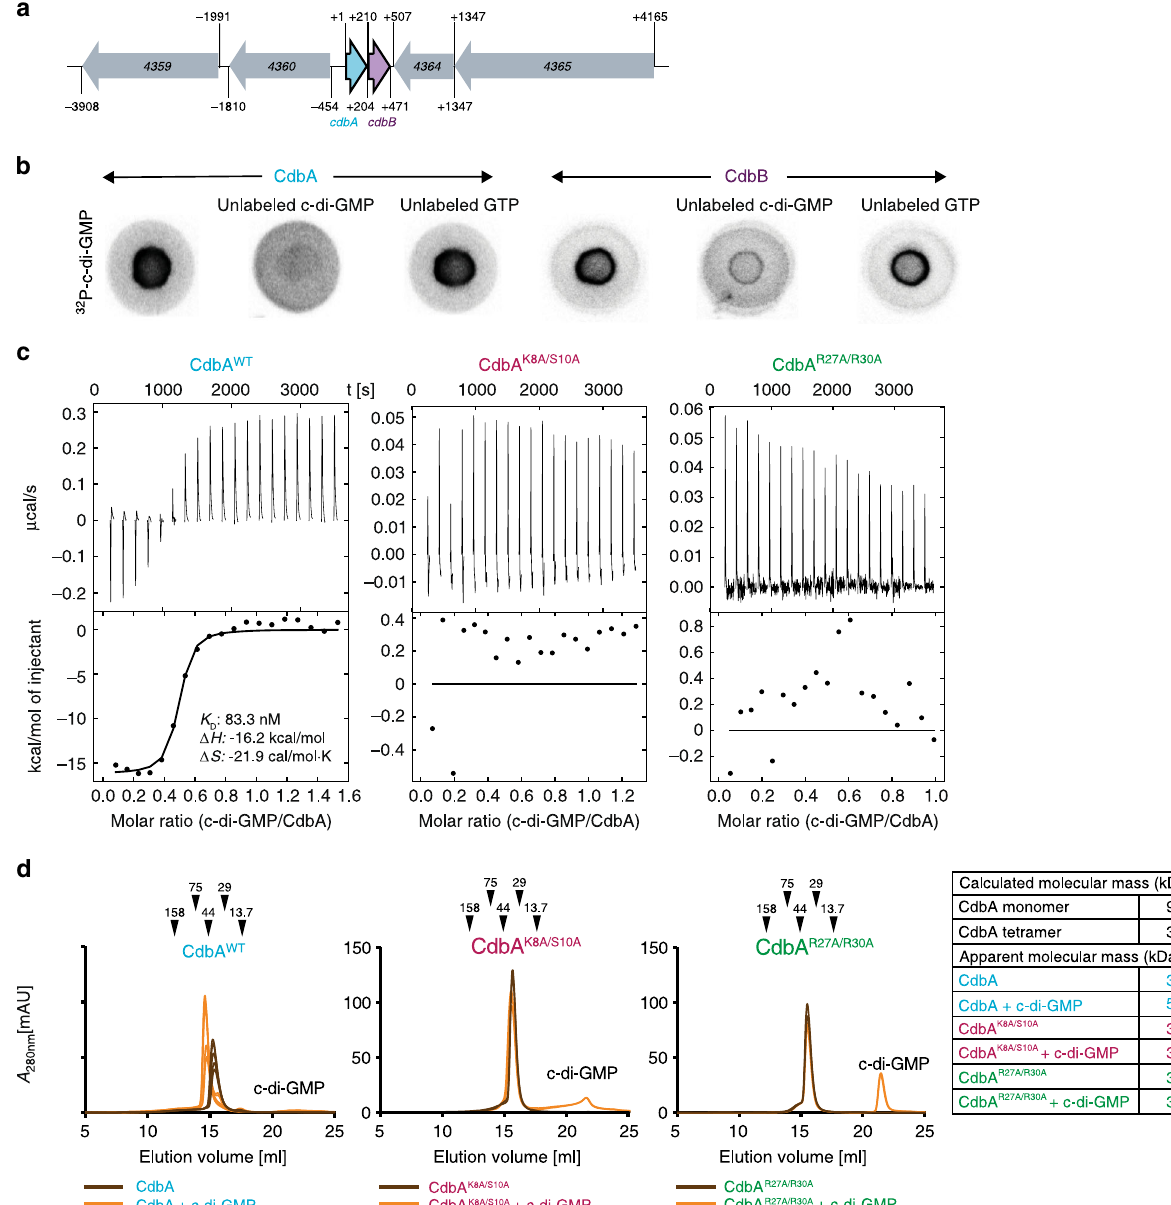
Fig. 1 CdbA and CdbB bind c-di-GMP in vitro. a cdbA-B locus. Start and stop codons are indicated. + 1 indicates fi rst nucleotide in the cdbA start codon. Arrows indicate direction of transcription. MXAN locus tags are indicated for the genes fl anking cdbA-B . See Supplementary Fig. 1 for annotation of these genes. b CdbA and CdbB binding to 32 P-c-di-GMP in DRaCALA in the absence and presence of unlabeled c-di-GMP and GTP. Similar results were obtained in two independent experiments. Source data are provided as a Source Data fi le. c ITC of c-di-GMP-binding to CdbA variants. In each experiment, the original titration traces (top panel) and integrated data (bottom panel) are shown. Solid line in the bottom panel represents the fi t of the integrated titration peaks to a one-site binding model. Dissociation constants ( K D ) and thermodynamic parameters are listed for CdbA WT for which binding was detected. d Analytical SEC of CdbA variants in the presence and absence of c-di-GMP. Arrows indicate elution volume and mass of molecular weight standards. n = 5 for CdbA WT , n = 2 for CdbA K8A/S10A and CdbA R27A/R30A . Table indicates calculated and apparent molecular mass of CdbA variants. Source data are provided as a Source Data fi